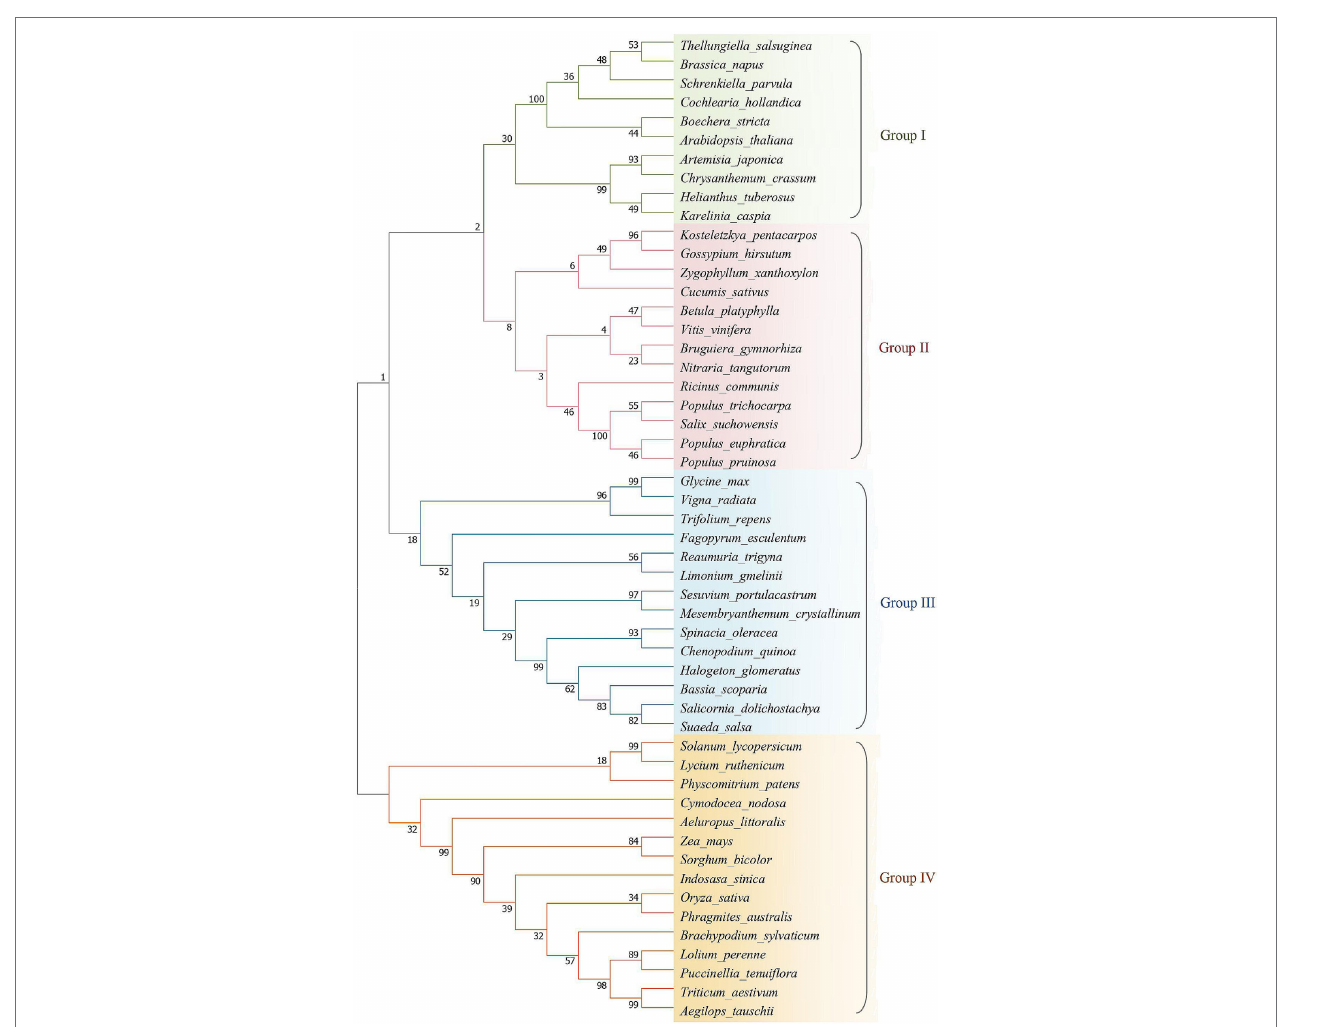
FIGURE 1 | Phylogenetic relationship analysis of salt overly sensitive 1 (SOS1) reported in plants. The amino acid sequences were aligned and the tree of sequence relationships generated using MEGA7. Classification was based on protein homology analysis, and groups of classifications were partitioned by different colors, each color representing the affinity of the plasma membrane Na + /H + antiporter SOS1 between different species. The plant sequences are known by their GenBank accession numbers and the accession numbers of these plant sequences as follow: Glycine max (AFD64746), Karelinia caspia (QOS02253), Fagopyrum esculentum (AVZ44366), Lolium perenne (AAY42598), Arabidopsis thaliana (OAP11543), Nitraria tangutorum (AGW30210), Reaumuria trigyna (AGW30208), Bruguiera gymnorhiza (ADK91080), Physcomitrium patens (CAM96566), Solanum lycopersicum (NP_001234698), Trifolium repens (AWS33581), Bassia scoparia (BAX01505), Halogeton glomeratus (AMK51995), Chrysanthemum crassum (BAR88076), Artemisia japonica (ALH21662), Spinacia oleracea (CDL70805), Salicornia dolichostachya (CDL70804), Triticum aestivum (AIA08676), Aeluropus littoralis (AEV89922), Limonium gmelinii (ACF05808), Chenopodium quinoa (ABS72166), Gossypium hirsutum (AKN19929), Vitis vinifera (NP_001268140), Oryza sativa (ATU90113), Cucumis sativus (NP_001292661), Lycium ruthenicum (QBF58650), Brassica napus (ACA50526), Populus pruinosa (AQN76710), Betula platyphylla (ALV66191), Populus euphratica (AQN76692), Ricinus communis (APR62626), Helianthus tuberosus (AGI04331), Suaeda salsa (AHJ14584), Boechera stricta (AHB86984), Vigna radiata (AGR34307), Indosasa sinica (AGB06353), Sesuvium portulacastrum (AFX68848), Cochlearia hollandica (AFF57539), Aegilops tauschii (CAX83737), Mesembryanthemum crystallinum (ABN04858), Cymodocea nodosa (CAD20320), Salix suchowensis (KAG5240570), Kosteletzkya pentacarpos (AIS92905), Zea mays (QOI16623), Schrenkiella parvula (ADQ43186), Zygophyllum xanthoxylon (ACZ57357), Brachypodium sylvaticum (ACO87666), Phragmites australis (BAF41923), Populus trichocarpa (AVA17745), Puccinellia tenuiflora (ABO32636), and Sorghum bicolor